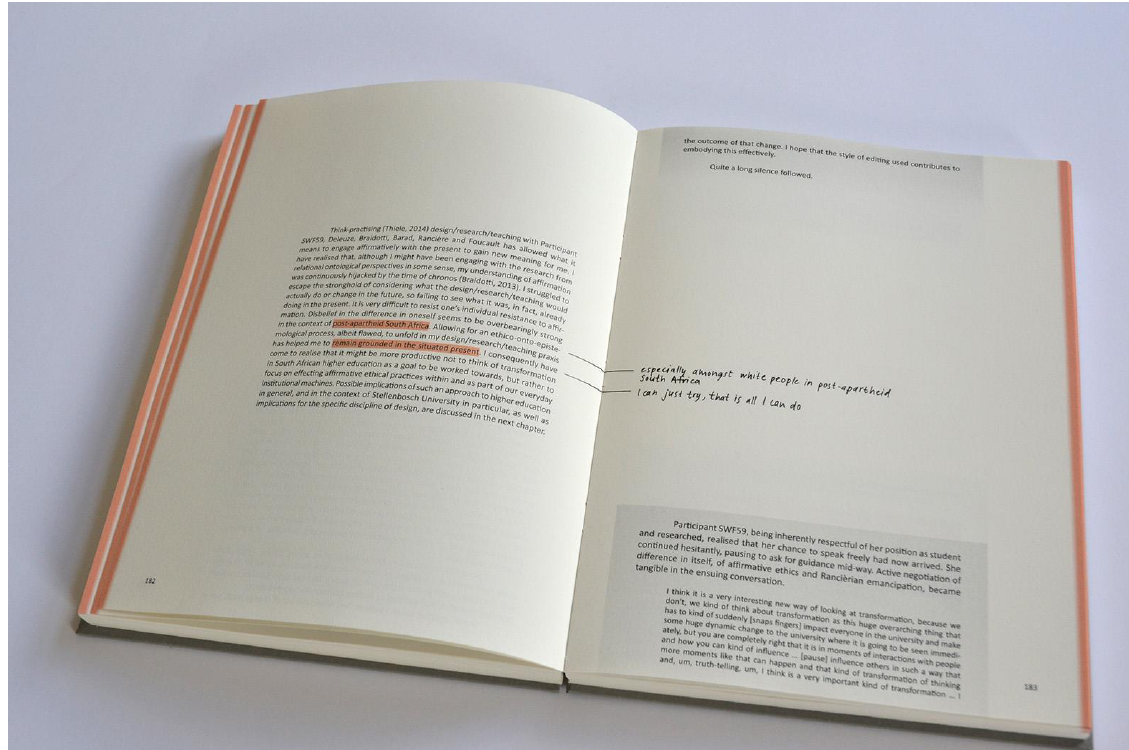
Figure 6 : The final form of the narratives. (Source: Perold-Bull, 2018) Whereas reading Narrative 1 (on the left-hand side of the double-page spread) has demonstrated the great difficulty experienced in trying to practise parrhesia, reading Narrative 2 (on the right-hand side of the double-page spread) in tandem has allowed for serendipitous moments of meaning generation to emerge progressively in-between. Accordingly, in forcing us to embody the positions of researchers, teachers, and students simultaneously, representational design practice allowed us, in the words of MacLure (2013: 666), to ‘engage [more] fully with the materiality of language and its challenge to the workings of representation. ’ Processes of yet unknown future change – serendipitous moments –